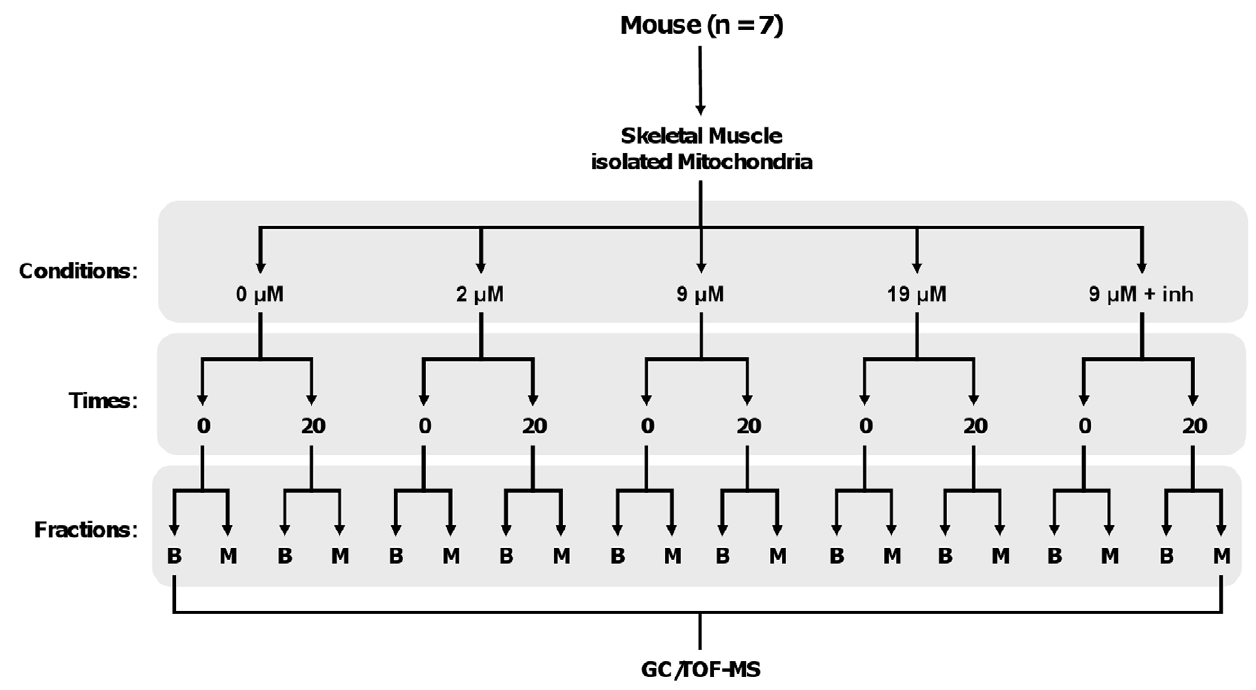
Figure 1. Summary of experimental design used to determine metabolite shifts in murine muscle mitochondrial preparations under different rates of LCFA b -oxidation. Conditions: incubations with/without palmitate, in the absence or presence of inhibitors (inh; 10 mM malonate, 5 m M rotenone). Times: subsamples of mitochondrial suspension removed at 0 and 20 min for subsequent metabolomics determinations. Fractions: mitochondrial suspensions were separated into matrix (M) and buffer (B). GC/TOF-MS: gas chromatography, time-of-flight mass spectroscopy.